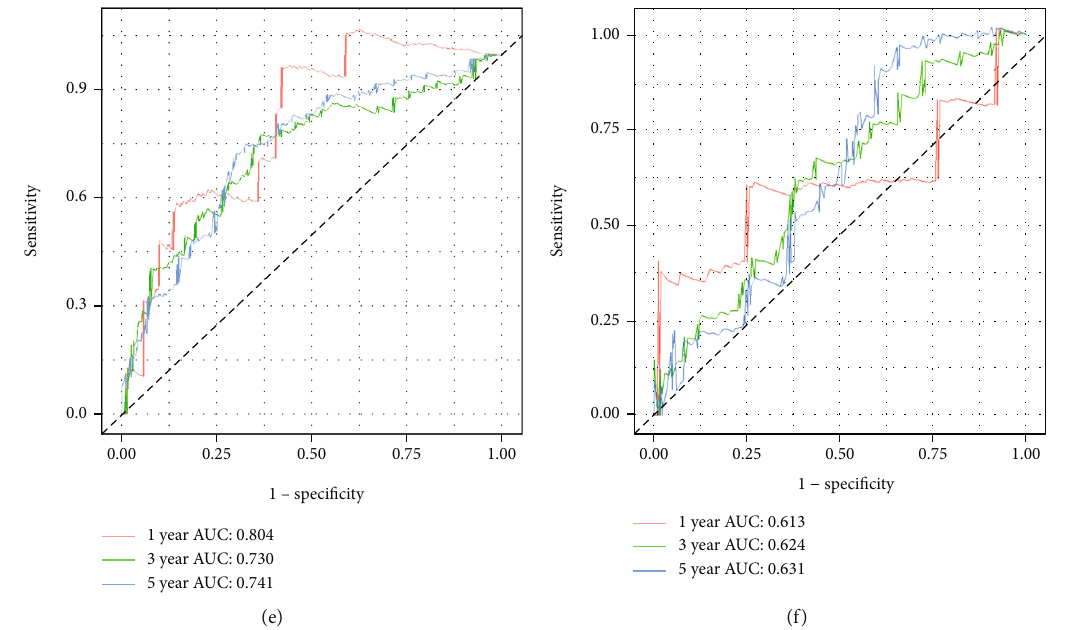
Figure 1: Correlation between the six IAGs and overall survival of cutaneous melanoma. (a) The least absolute shrinkage and selection operator (LASSO) Cox regression method. (b) The regression coe ffi cient of the optimal prognostic IAGs. (c) Kaplan-Meier curves of overall survival of the high-risk and low-risk groups in (c) the training set and (d) the testing set. The ROC curves of 1-year, 3-year and 5- year OS in (e) the training set and (f) the testing set. IAGs: immune-associated genes; OS: overall survival; ROC: receiver operating